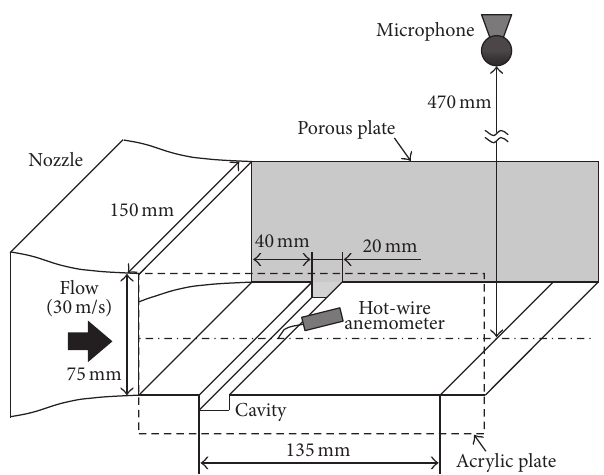
Figure 2: Schematics for experimental